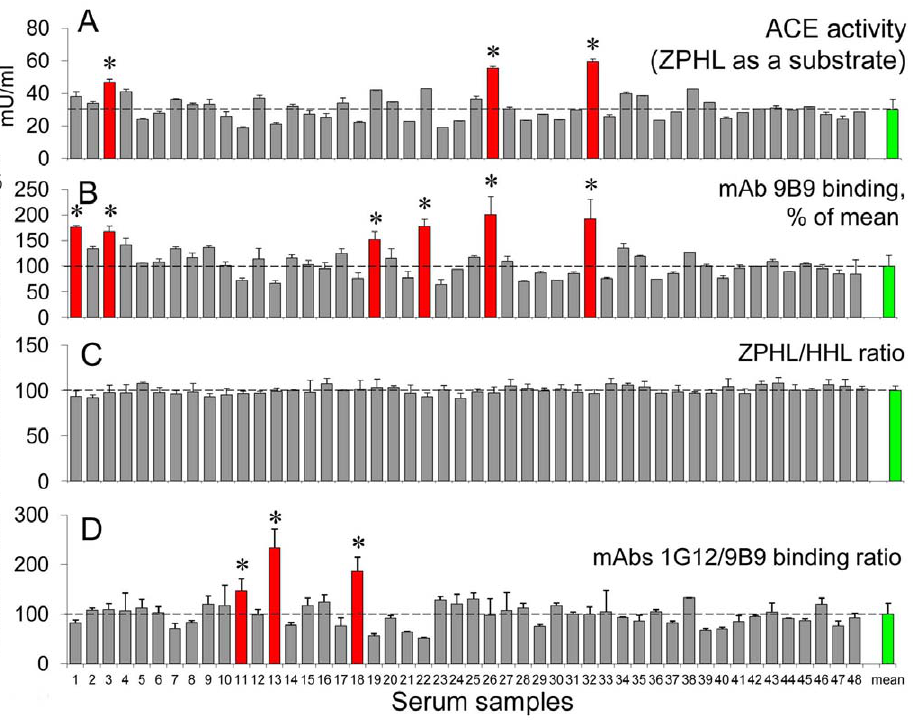
Figure 8. Blood ACE phenotyping in healthy donors. A . ACE activity in serum of healthy young donors was determined as in Figure 3. B. ACE activity precipitated from serum of healthy donors by mAb 9B9 (estimation of relative ACE protein content). C. The ratio of the rates of the hydrolysis of two substrates (ZPHL/HHL ratio) for tested serum samples was determined as in Figure 3. D . ACE activity precipitated from serum of healthy donors by mAbs 9B9 and 1G12 and expressed as their ratio for each serum sample. The red color of the bar shows serum of those patients whose tested parameters were significantly higher (and yellow bar – significantly lower) than mean value for all samples (green bars). Results are shown as mean 6 SD of 4 independent experiments, each in duplicates or triplicates. *, statistically significant difference (p , 0.05) from the mean value.